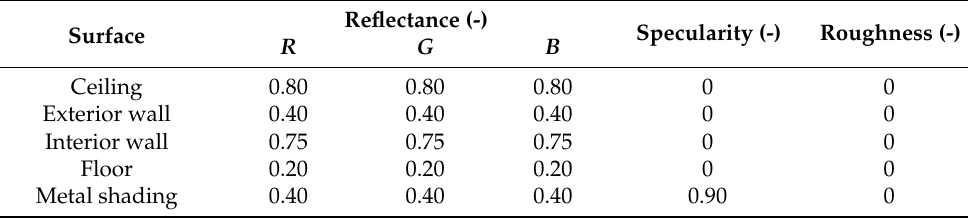
Figure 3. Grasshopper definition and its main simulation workflow. Table 2. Radiance material properties of various surfaces in the model.